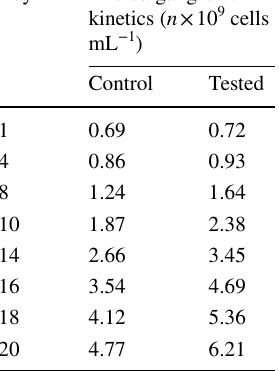
growth kinetics